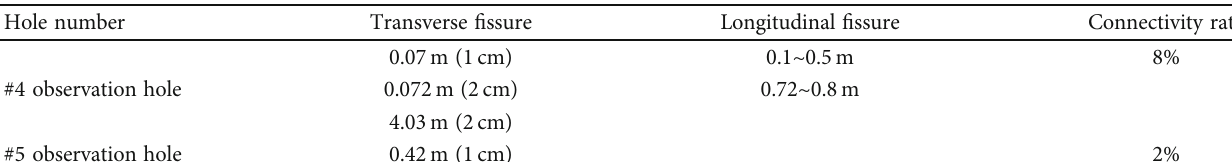
Figure 9: The observation of blast hole and #4 Table 3: Results of drilling inspection.